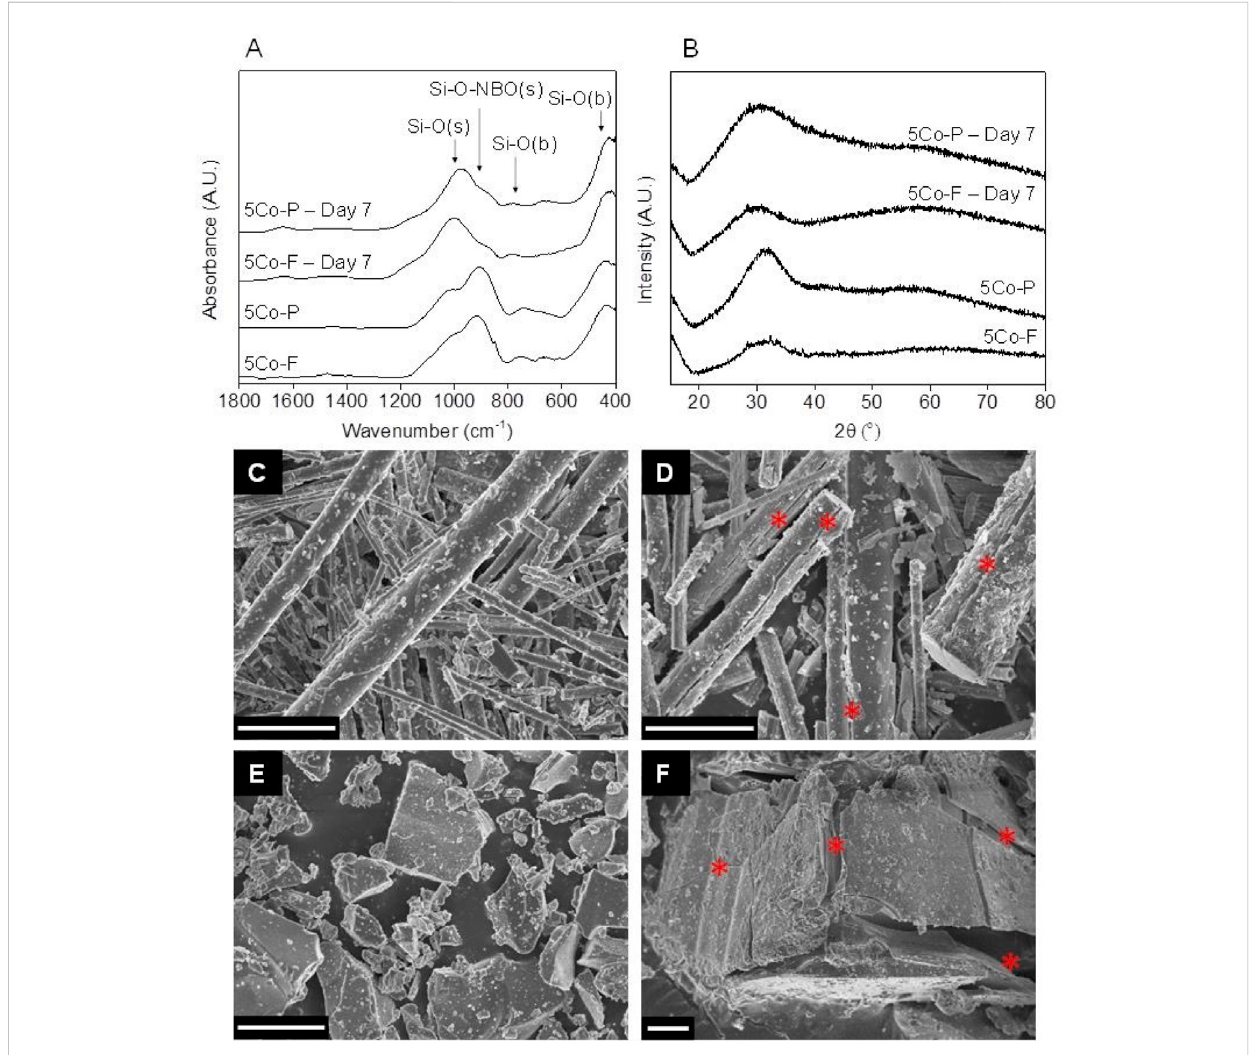
FIGURE 3 FTIR (A) and XRD (B) of the glasses containing cobalt before and after incubation in DMEM for 7 days: 5Co fi bres (5Co-F) and particles (5Co-P); SEM images of 5Co-F before (C) and after (D) incubation in DMEM for 7 days, and 5Co-P before (E) and after (F) incubation in DMEM at a concentration of 1.5 mg ml − 1 . Scale bar is 10 μ m, and * indicates cracks forming in the fi bres and particles after incubation in